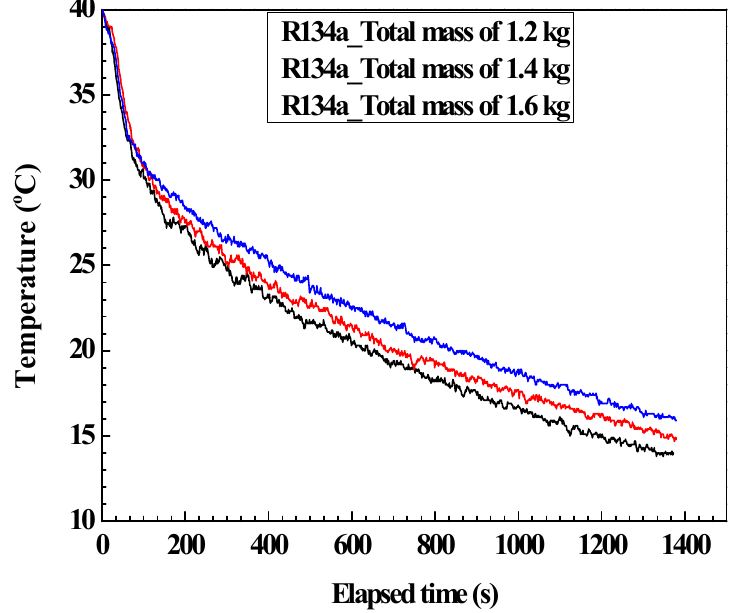
Figure 4. Cooling speeds of the two parallel refrigeration cycles with the refrigerant charge amount for a special purpose vehicle